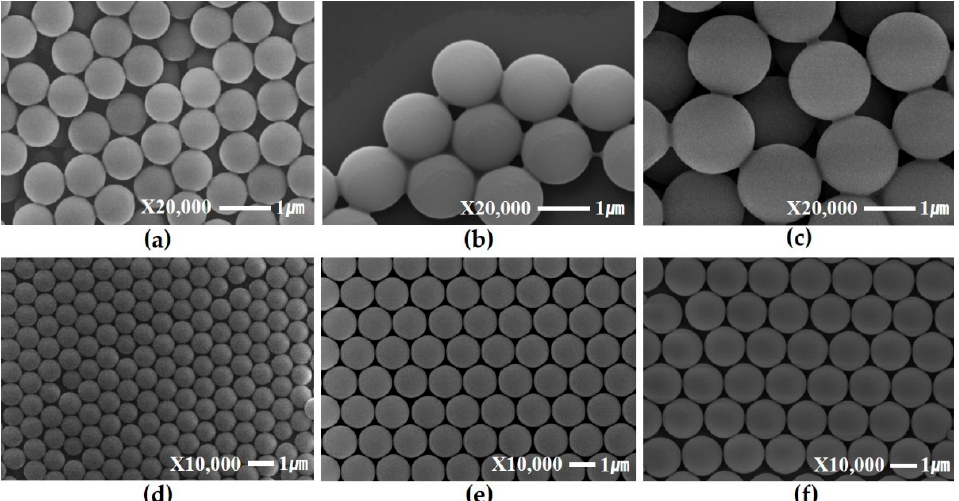
Figure 1. FE-SEM images of synthesized PS spheres with diameters of about ( a ) 800 nm; ( b ) 1300 nm; ( c ) 1600 nm and monolayers of ( d ) 800 nm; ( e ) 1300 nm and ( f ) 1600 nm.